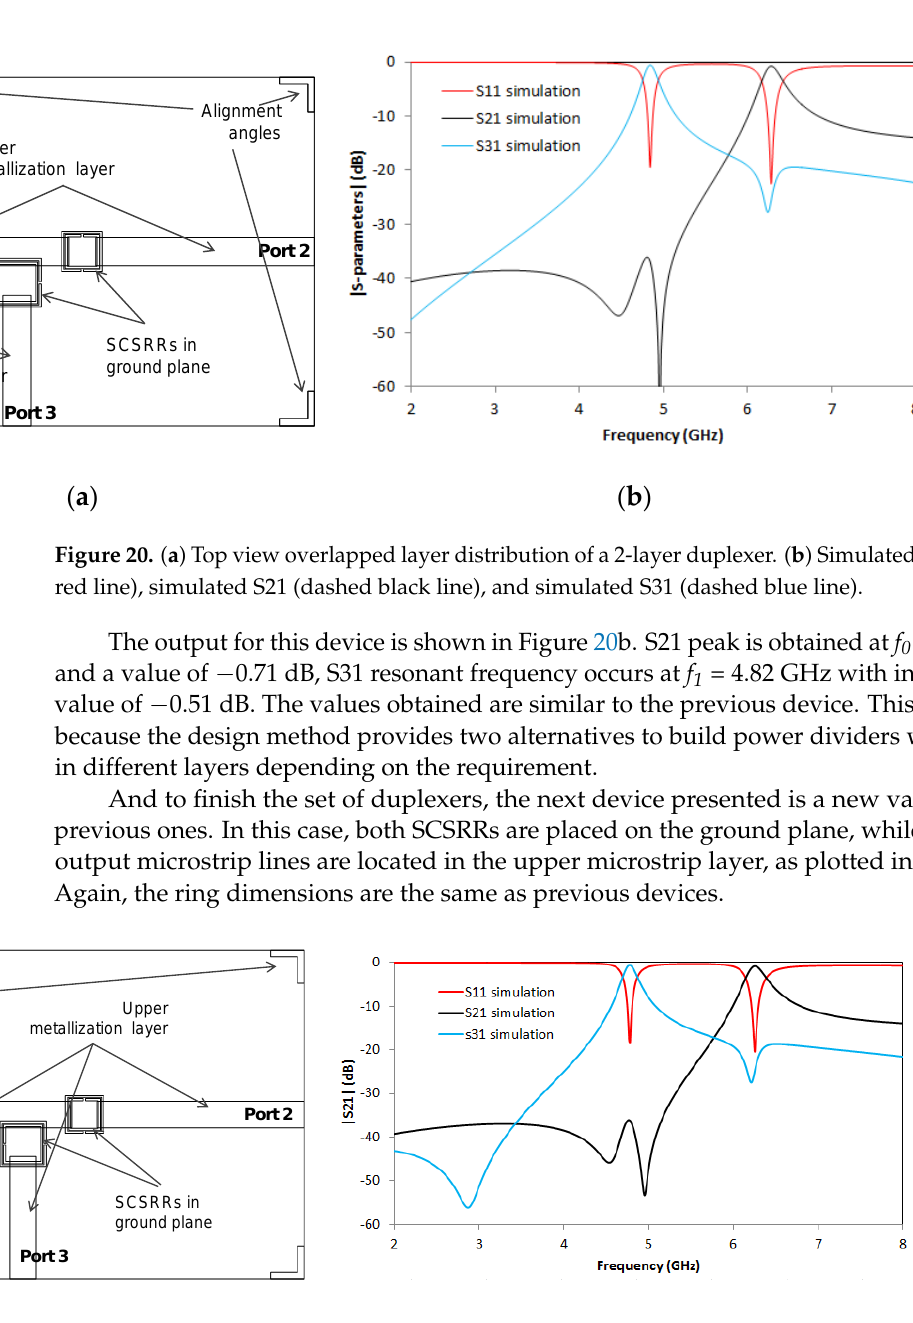
Table 4. Comparison between different models of diplexers.